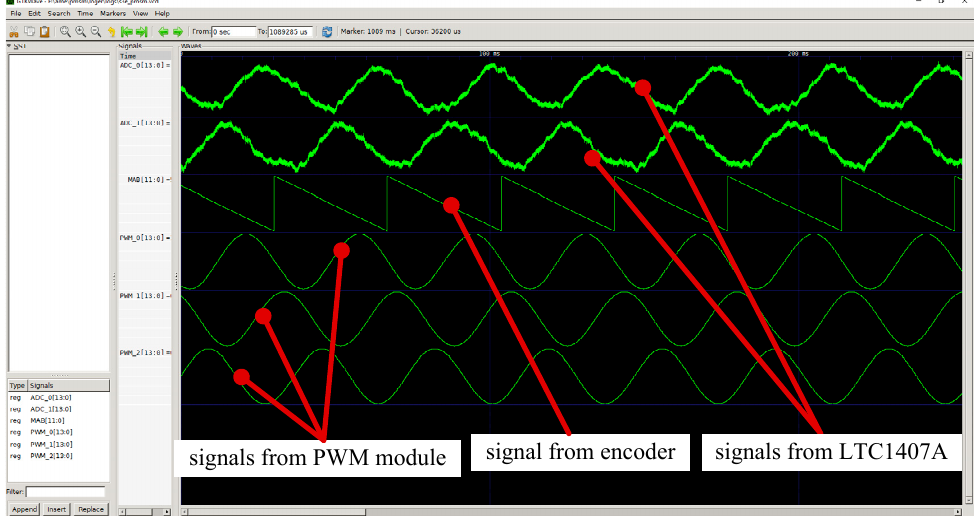
signals from PWM module signal from encoder